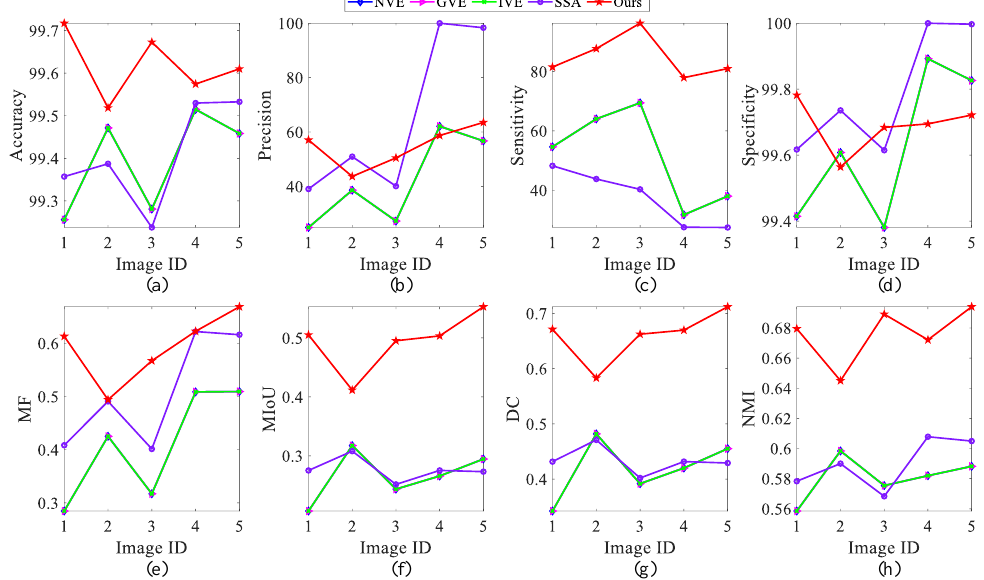
Figure 6. Quantitative comparison in terms of ( a ) accuracy(%), ( b ) precision(%), ( c ) sensitivity(%), ( d ) specificity(%), ( e ) MF, ( f ) MIoU, ( g ) DC, and ( h ) NMI, where the x axis is Image ID. Our method significantly outperforms these evaluated defect detection algorithms across five randomly selected crack defect